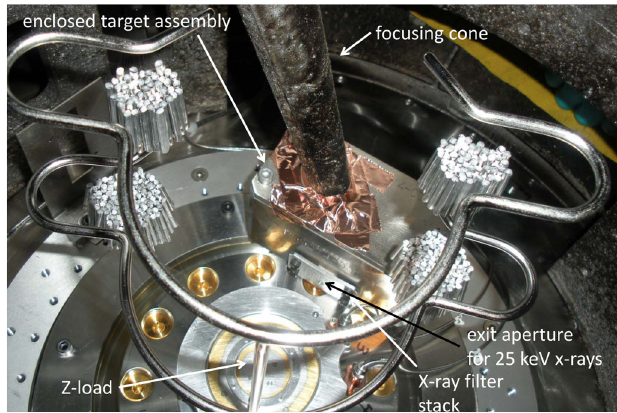
FIG. 9. (Color) Fully installed target can inside the Z -center section. The laser light is guided through the focusing cone into the target housing where it generates x rays that can escape through the filtered 3 mm exit